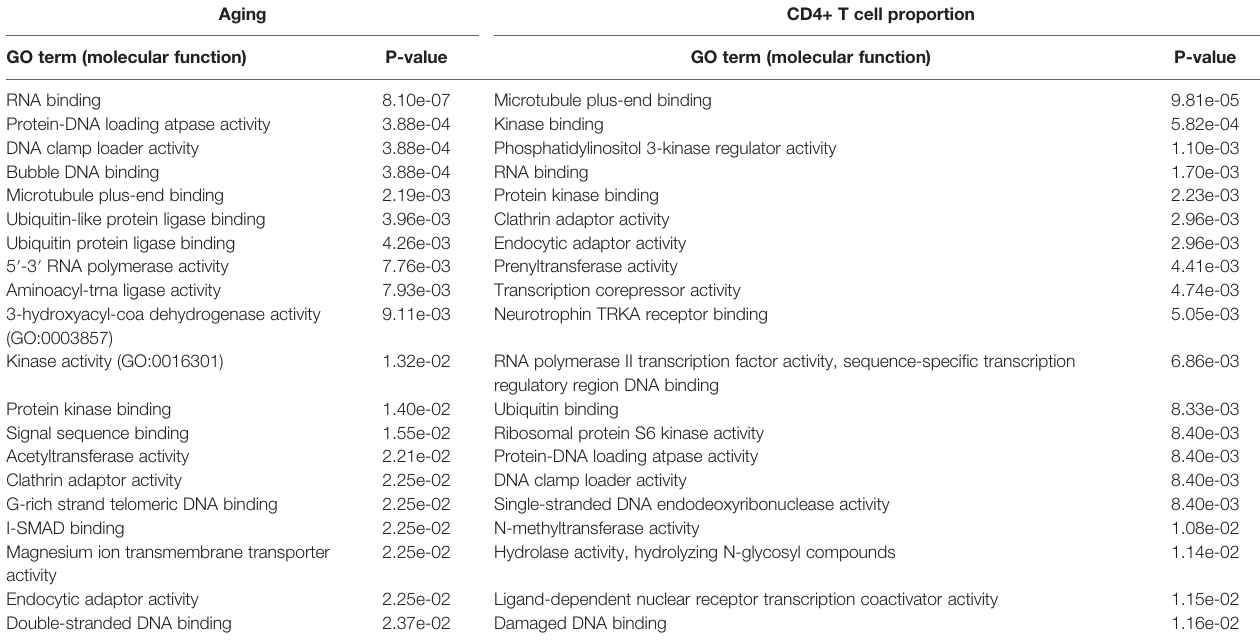
TABLE 2 | The signi fi cantly enriched GO molecular function terms of the aging- and CD4+ T cell proportion-derived differential genes (top 20).